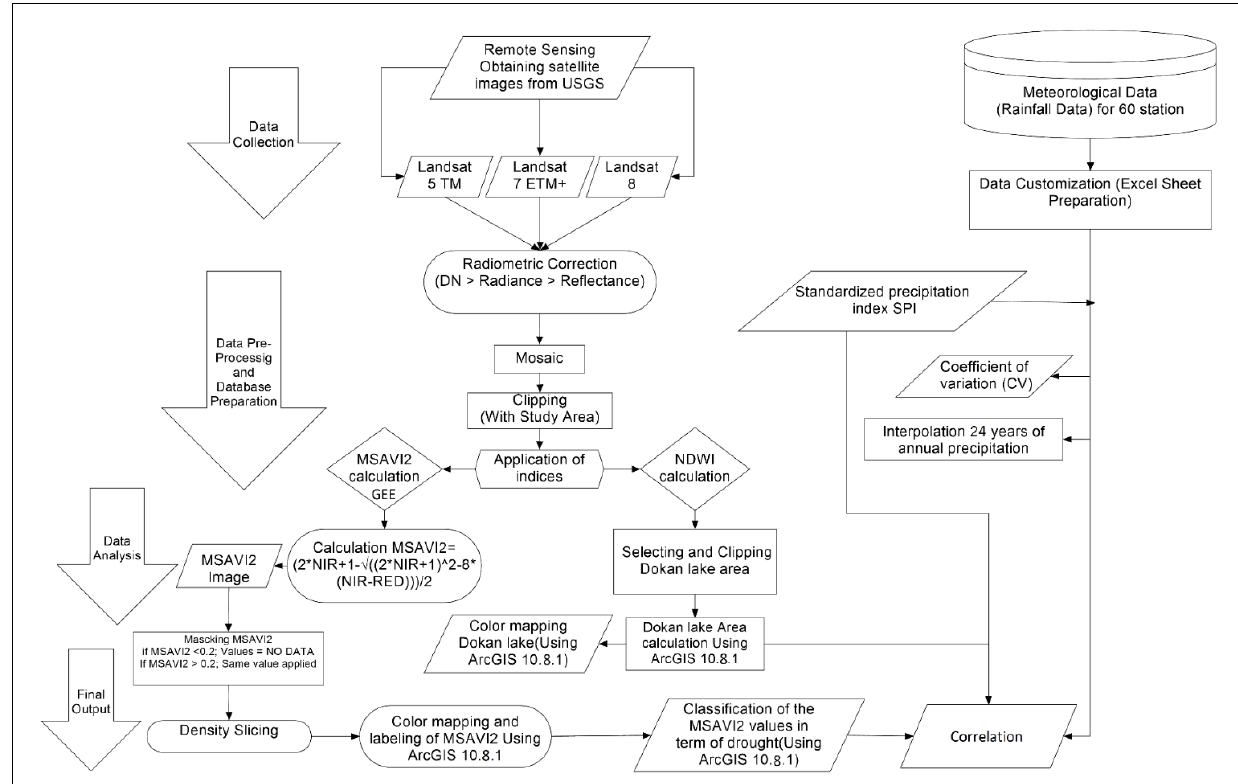
Figure 2. Flowchart of the methodology.